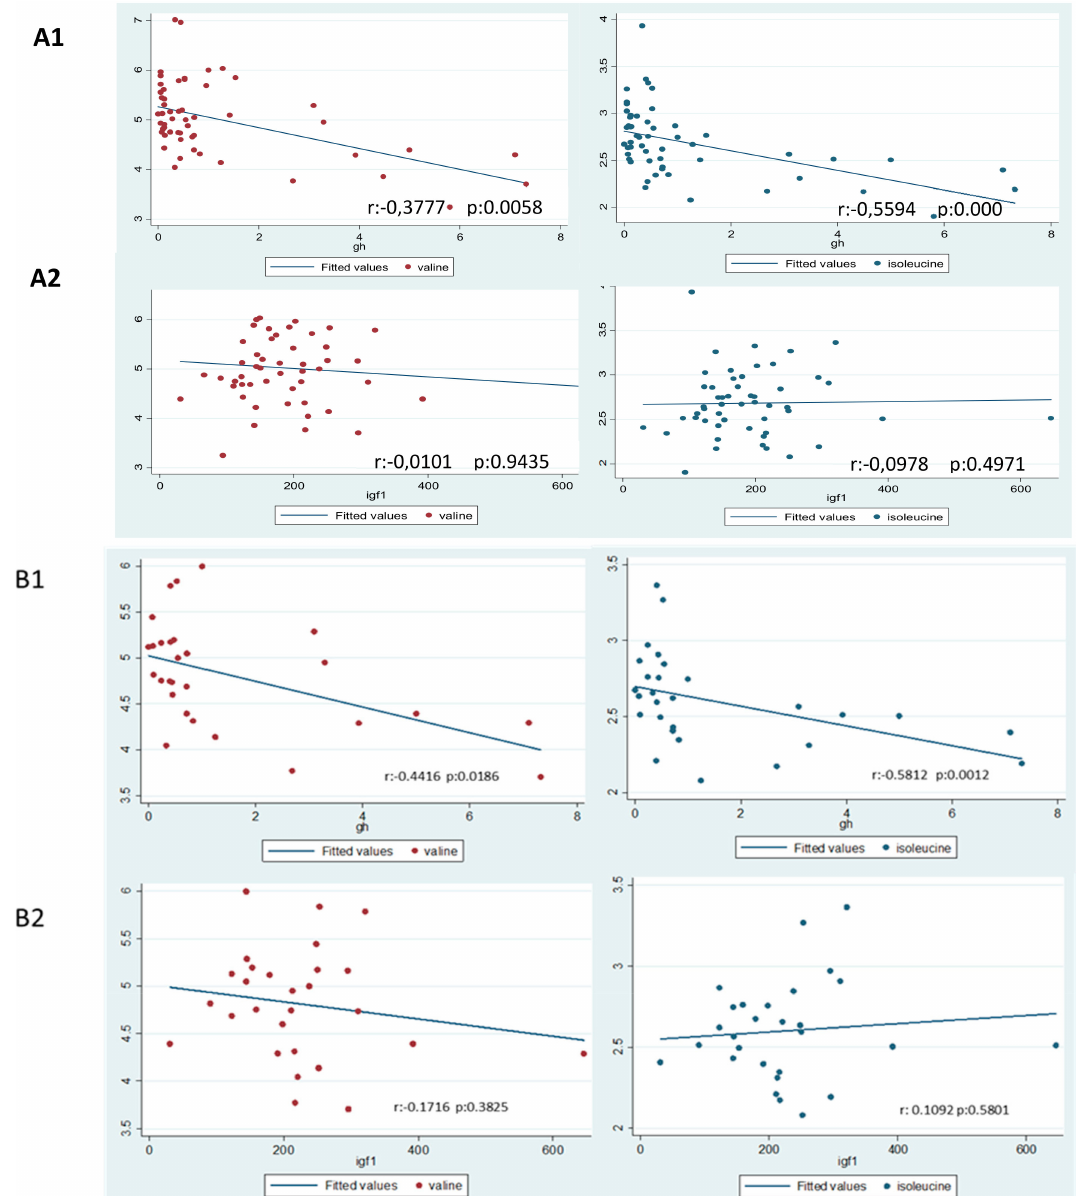
Figure 2. Correlations ( A ) in the whole group and ( B ) in acromegaly (ACRO) patients. r : Spearman’s rank correlation coe ffi cient. The figure shows branched-chain amino acid (BCAAs) (valine and isoleucine) Spearman correlations with growth hormone (GH) and insulin-like growth factor-1 (IGF-1) in the whole group ( A1 and A2 ) and in ACRO group ( B1 and B2 ). GH and IGF-1 are expressed in ng / mL and BCAAs are expressed in arbitrary units